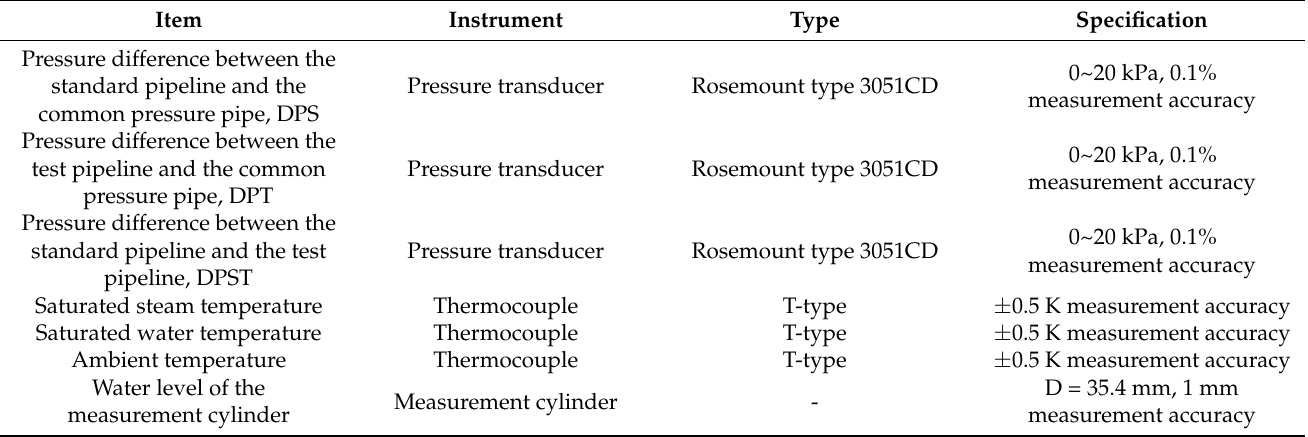
Table 1. Instruments for the